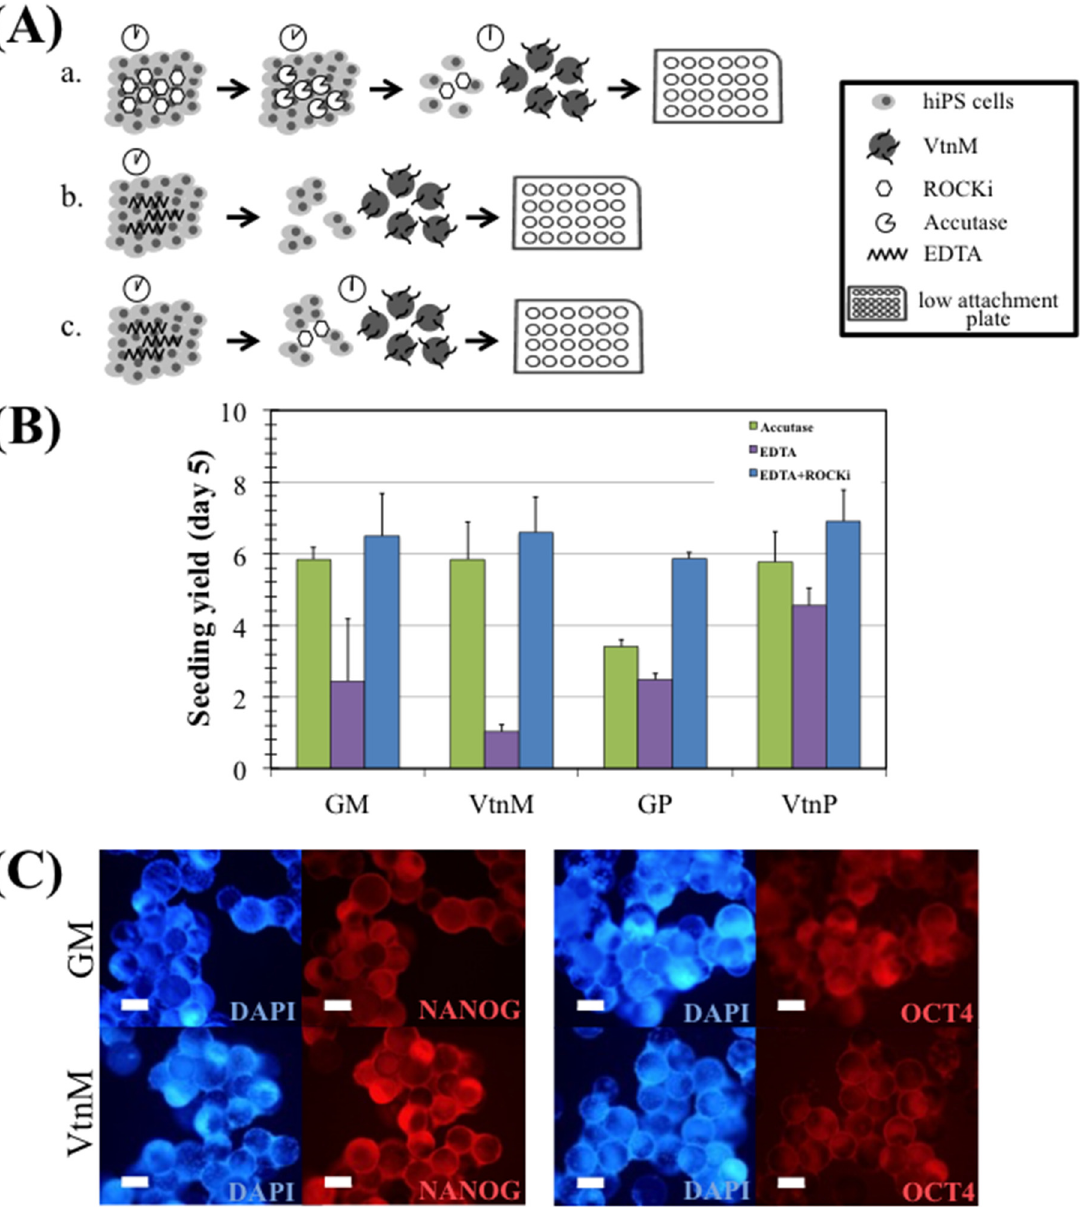
Fig 2. hiPS cell expansion on microcarriers in E8 medium, under static conditions. (A) Three different inoculation strategies: a. accutase, b. EDTA and c. EDTA+ROCKi were compared. (B) Seeding yield after 5 days of culture of hiPS cells on Geltrex coated polystyrene microcarriers (GM) and plate (GP), vitronectin coated polystyrene microcarriers (VtnM) and plate (VtnP), using the three different inoculation strategies: accutase (green), EDTA (purple) and EDTA+ROCKi (blue). Cells were inoculated at a 5x10 4 cells/cm 2 density. Error bars represent SEM (standard error of the mean). Three replicate wells were performed for each condition. (C) Immunostaining of hiPS cells cultured on microcarriers with E8 medium at day 5. Cells were stained for pluripotency markers NANOG (left panel) and OCT4 (right panel), and nuclei counterstained with DAPI. Scale bars – 100 μ